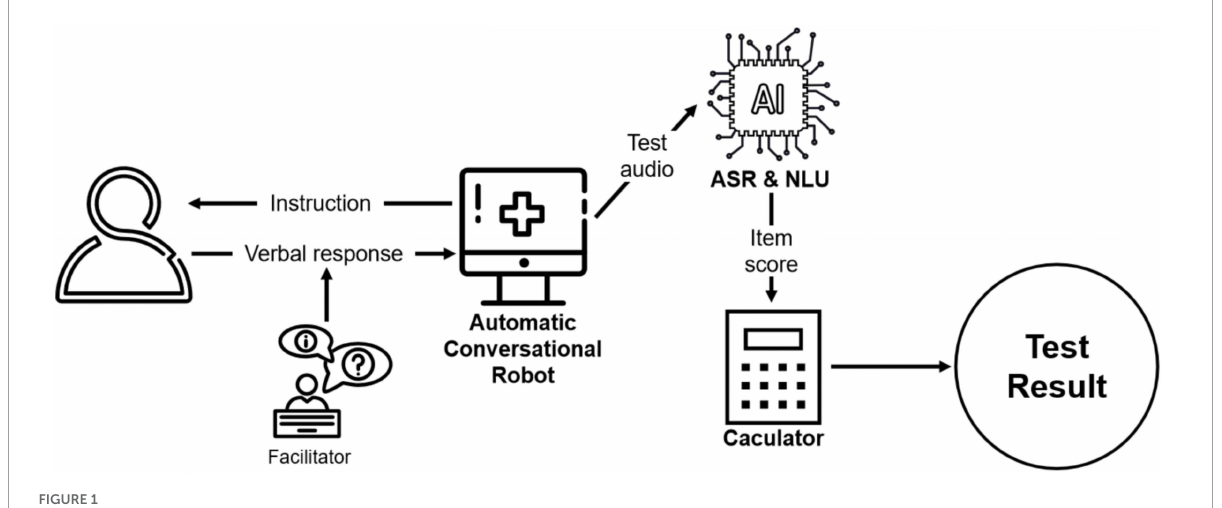
FIGURE1 Administration process of